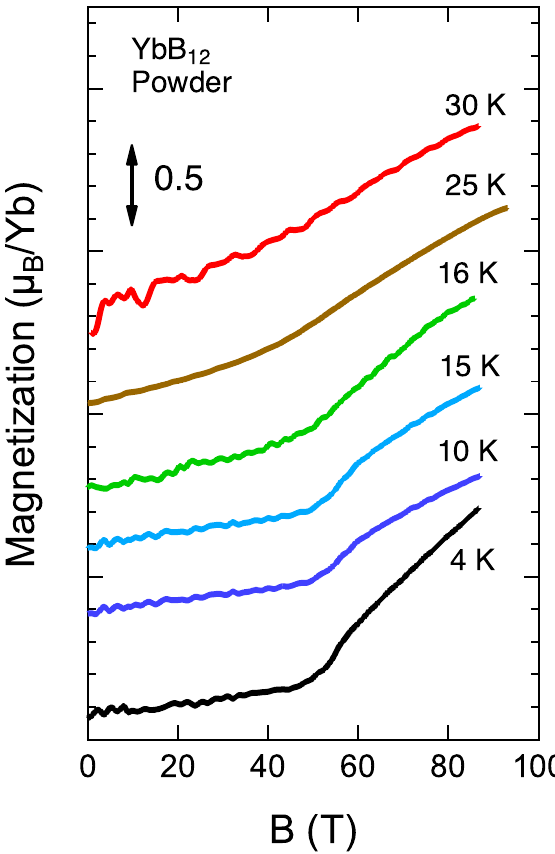
Figure 1. Magnetization processes of powdered samples of YbB 12 at different temperatures. The field-ascending processes are shown. Each curve was vertically shifted for better